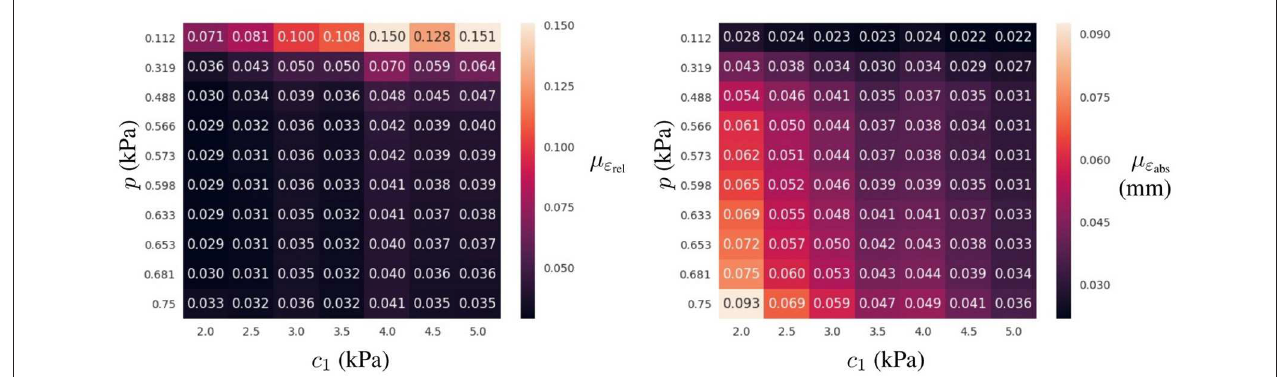
FIGURE 6 | Prediction error for the best-ranked surrogate model (4 layers of 64 neurons trained in (cid:127) learn ) for the testing dataset: mean ε value (Left) and mean absolute displacement error (Right) for a given loading condition ( p in the vertical axis) and material property ( c 1 in the horizontal axis) across all geometries in the testing dataset.